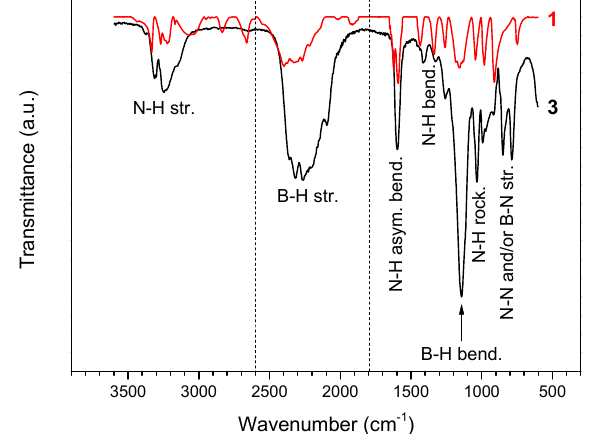
Figure 2. FTIR spectrum of 3 and, for comparison, that of 1 (N 2 H 4 BH 3 ). The different vibrational modes are indicated.